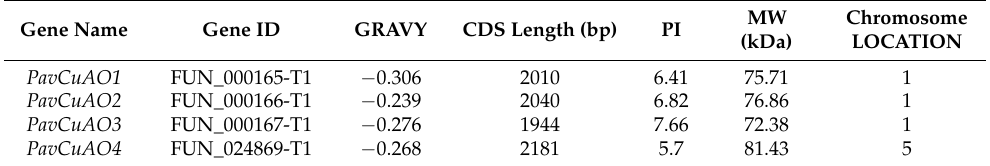
Table 1. Description of the PavCuAO genes.